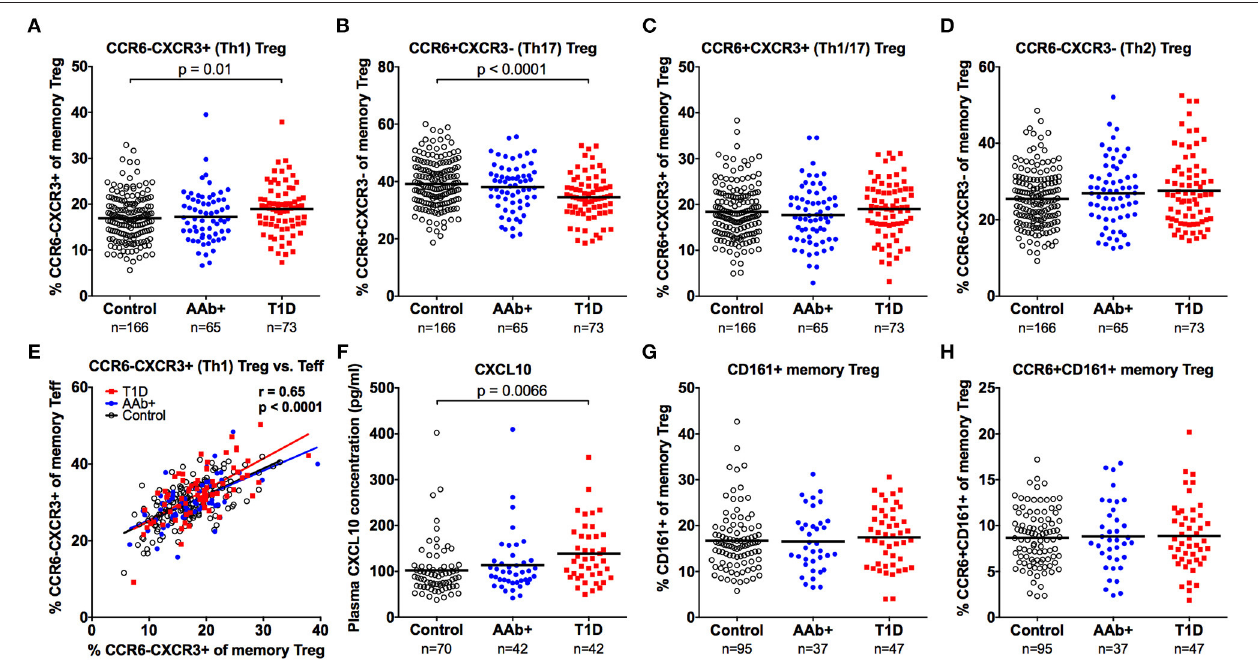
FIGURE 6 | Increased frequency of CXCR3 + memory Tregs and increased plasma CXCL10 levels in children with newly diagnosed T1D. Frequencies of CCR6-CXCR3 + (A) , CCR6 + CXCR3- (B) , CCR6 + CXCR3 + (C) , and CCR6-CXCR3- (D) memory Tregs in control, AAb + and T1D groups. Linear regression lines of CCR6-CXCR3 + memory Tregs against Teffs were calculated for the control (black lines), AAb + (blue lines) and T1D (red lines) groups (E) . Correlation was calculated by pooling all samples analyzed and is expressed together with the P value next to the plot. Plasma CXCL10 levels (F) , and CD161 + (G) and CCR6 + CD161 + (H) memory Treg frequencies in control, AAb + and T1D